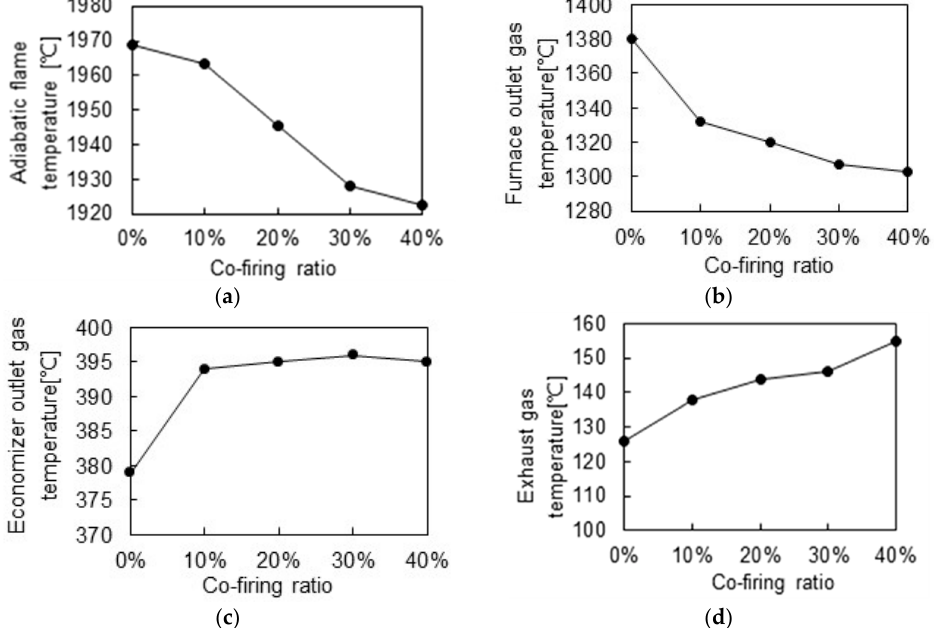
Figure 5. Effect of ammonia co-firing on the gas temperatures in the boiler, ( a ) adiabatic flame temperature and flue gas temperatures at ( b ) furnace exit, ( c ) economizer outlet and ( d ) boiler exit.